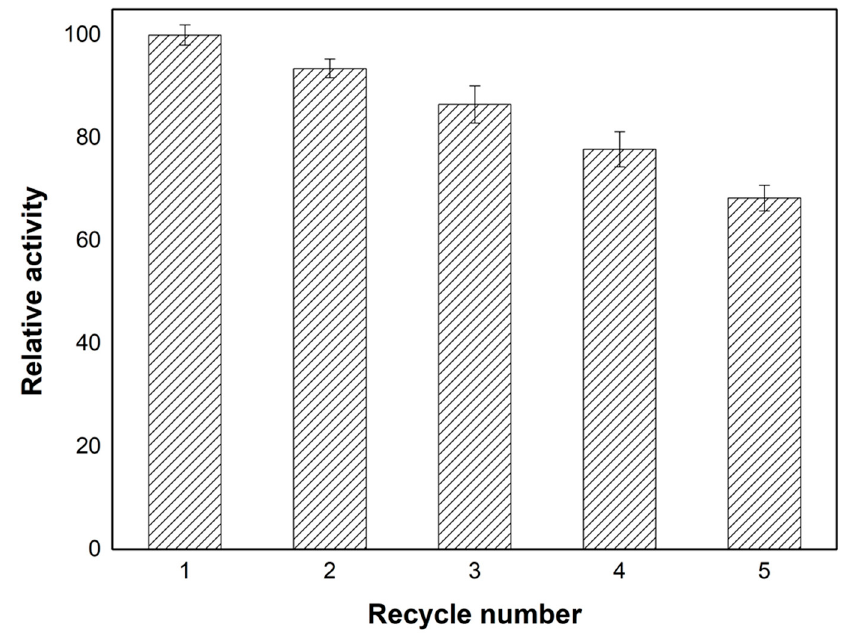
Figure 8. Reusability of Lip–Glu–A–SC for biodiesel production. Reaction conditions: methanol/oil molar ratio,4:1; immobilized lipase dosage, 0.6 g; reaction time, 30 h; and reaction temperature, 45 °C.